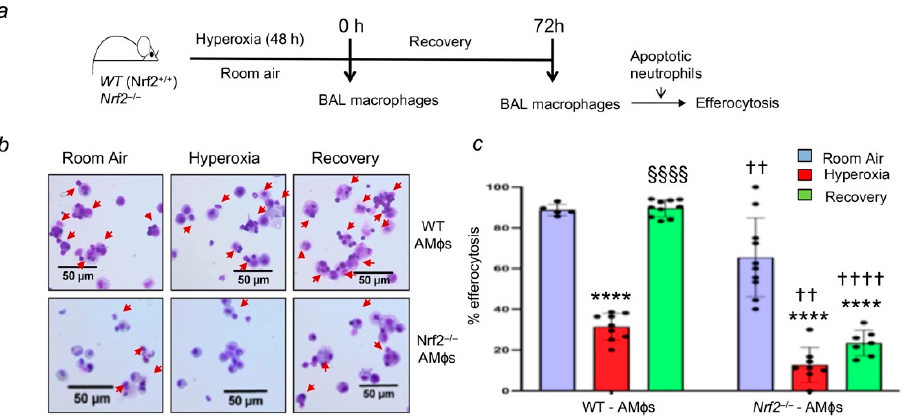
Figure 1. Hyperoxia impairs alveolar macrophage-mediated efferocytosis, and Nrf2-deficiency worsens it in vivo. Nrf2 +/+ (WT) and Nrf2 − / − mice ( n = 3 per group) were exposed to room air or hyperoxia for 48 h, and a set of hyperoxia-exposed mice were allowed to recover at room air for 72 as outlined in schema. ( a ) BAL from these mice was obtained, and macrophages were incubated on cover glasses with apoptotic neutrophils for 1 h. Macrophages were washed to remove unbound/non-internalized apoptotic cells and stained with Diff Quick stain. Images were captured to quantify apoptotic neutrophil binding, and internalization (indicated by red arrows). ( b ) Representative images of macrophages with neutrophils for each experimental condition are shown. ( c ) The number of apoptotic neutrophils either bound or internalized by macrophages from ~5–9 fields were quantified and expressed as % efferocytosis. Versus room air of respective genotypes, † Nrf2 − / − versus WT counterparts, § hyperoxia vs. recovery; †† p < 0.01; ****/§§§§/†††† p < 0.0001. Purple, room air group; Red, hyperoxia group; Green, hyperoxia and recovery.